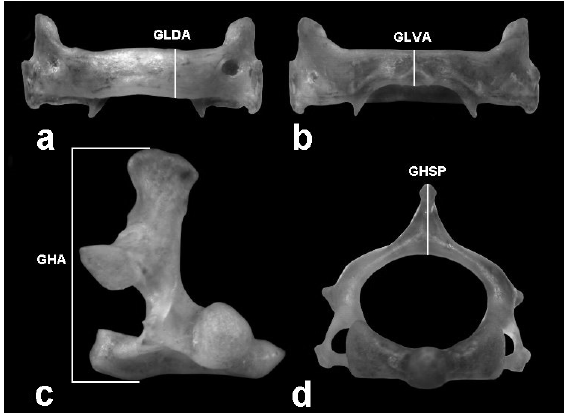
Figure 1 - Measurements: a ) GLDA, greatest length of dorsal arch of atlas; b ) GLVA, greatest length of ventral arch of atlas; c ) GHA, greatest height of axis; d ) GHSP, greatest height of spinous process of axis. See Materials and Methods for definition of the